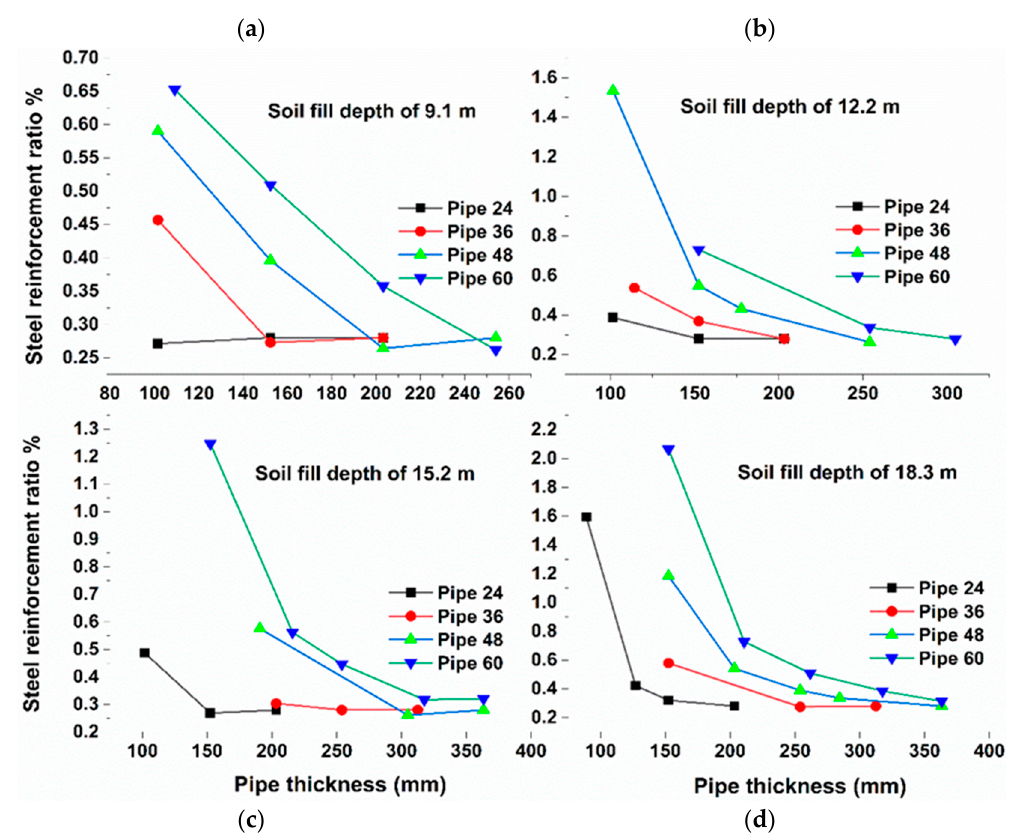
Figure 7. Required steel ratio versus reinforced concrete pipe thickness for various soil fill depths. Table 5. The optimum thickness of the analyzed reinforced concrete pipes.